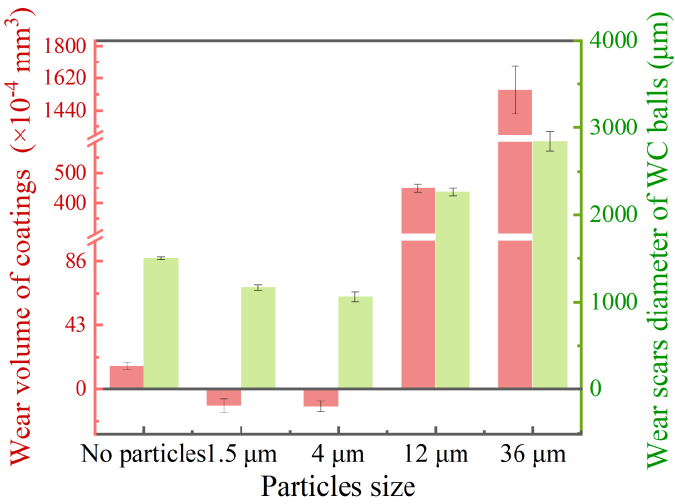
Figure 8. Wear loss of tribo-pairs: Left: wear volume of coatings; Right: wear scars diameter of WC balls.